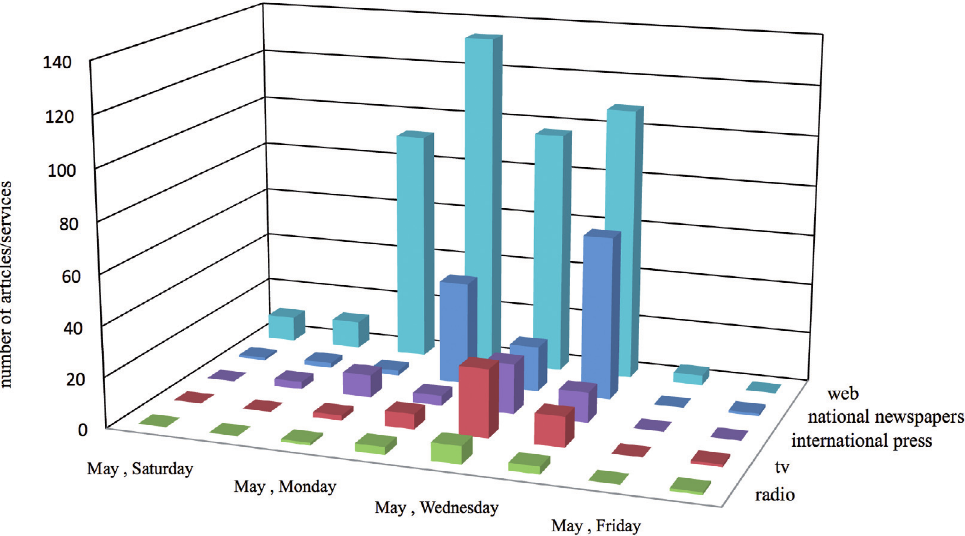
Figure 6. The number of articles on the web, in newspapers and in national magazines, and in the international press, and the number of interviews on television and radio services, from May 7 to May 14, 2011. Only the articles and interviews mentioning INGV are